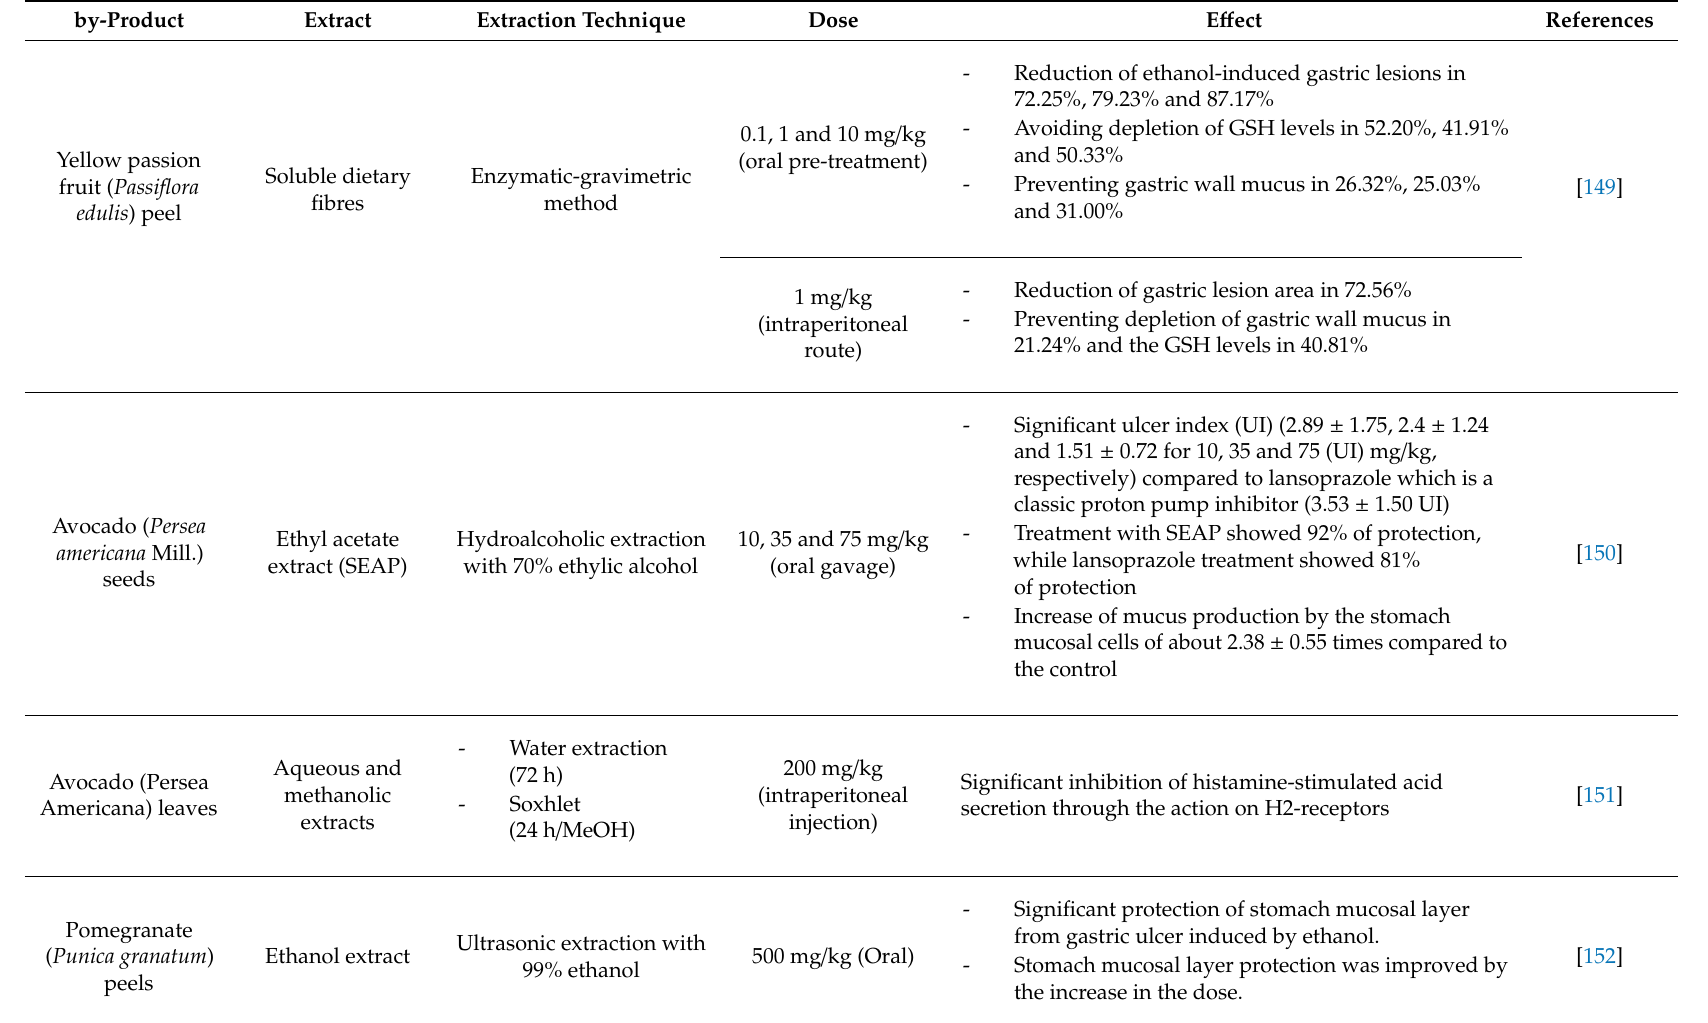
Table 6. E ff ects of some fruit by-products on intestinal